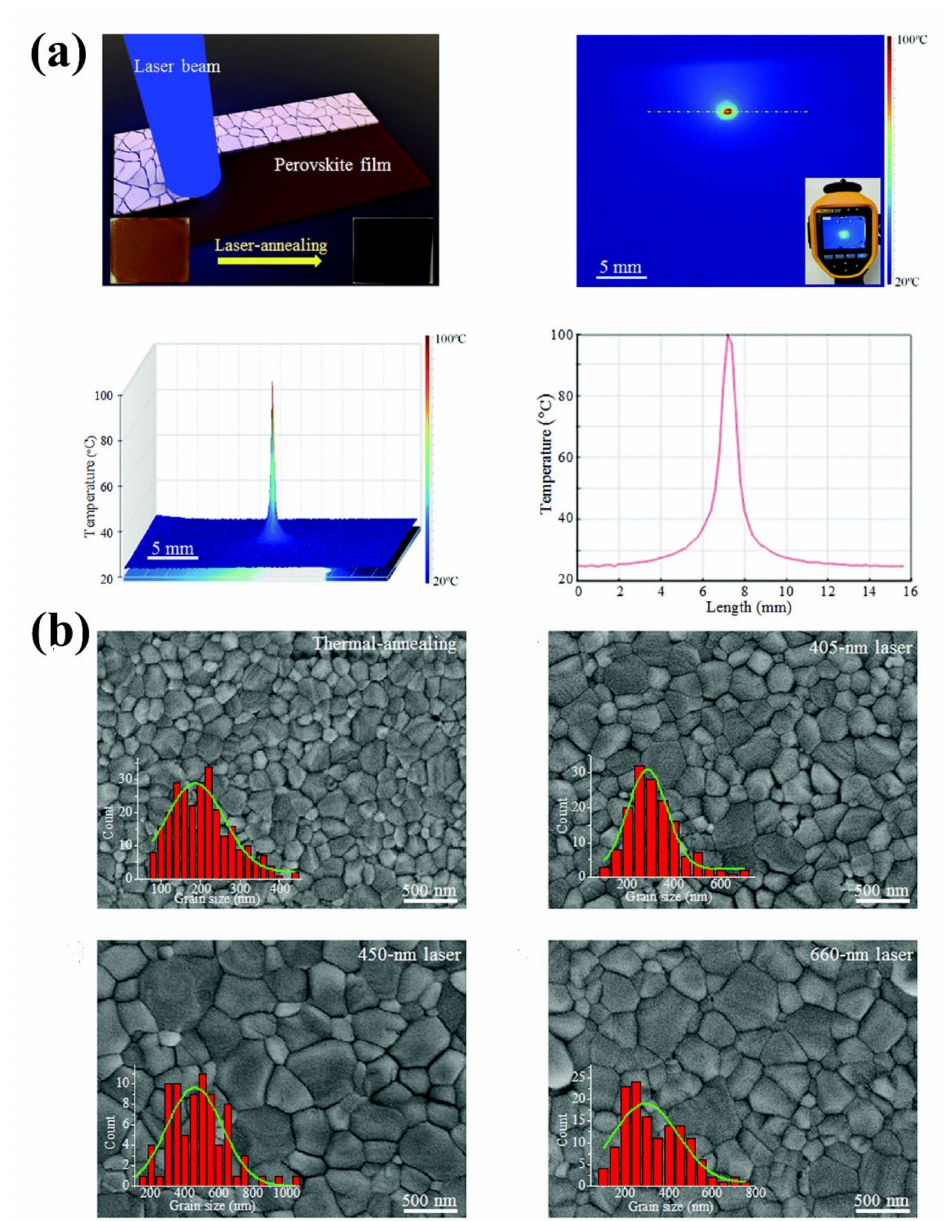
Figure 9. ( a ) Schematic illustration of the laser annealing process. 2D and 3D infrared thermal images of the perovskite film surface during the laser annealing process; temperature distribution on the film surface; XRD spectra of films; MAPbI 3 perovskite film patterned with focused laser beam. ( b ) SEM images of films fabricated by thermal-annealing and laser-annealing processes (from left to right). Reprinted with permission from Ref. [23]. Copyright 2020 Royal Society of